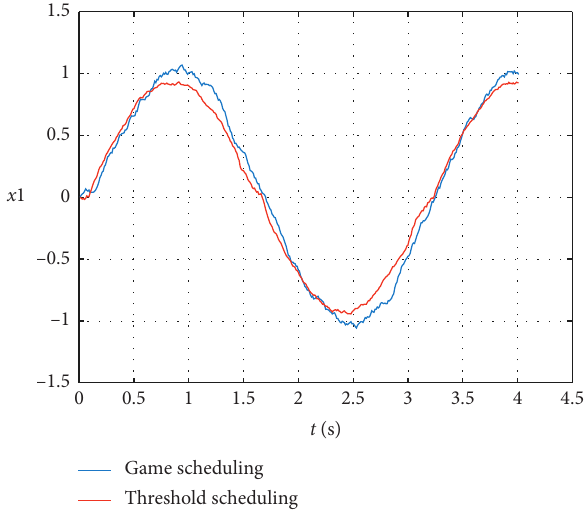
Figure 11: Comparison of tracking control between noncooper- ative game HOSMC and threshold adaptive SMC.